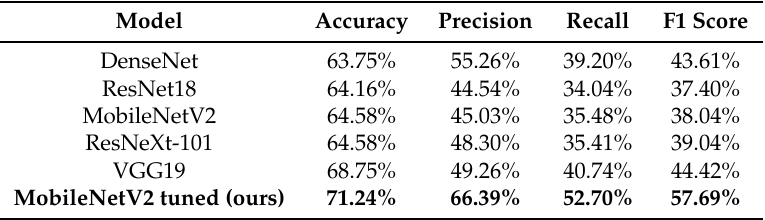
Table 5. Baselines and tuned MobileNetV2 metrics measured on the acetic acid images.